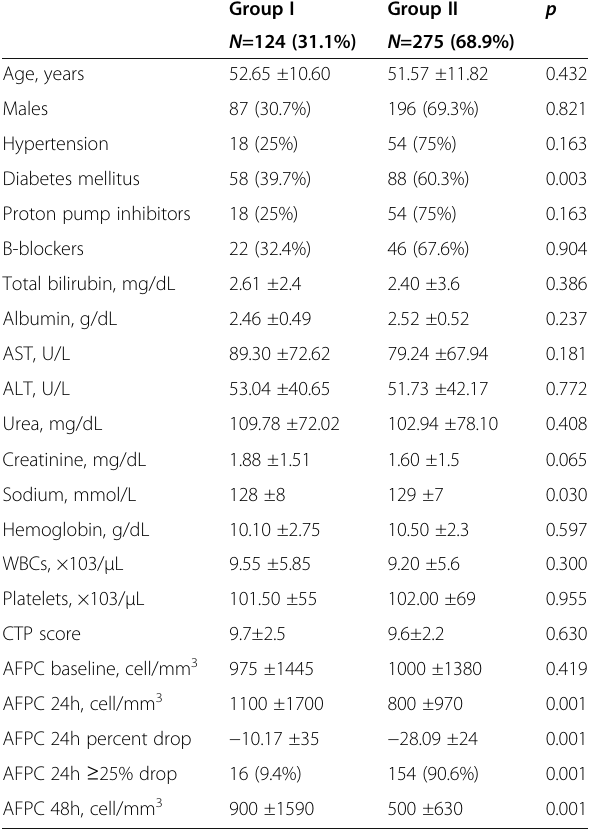
Table 1 Comparative demographic, clinical, and laboratory data